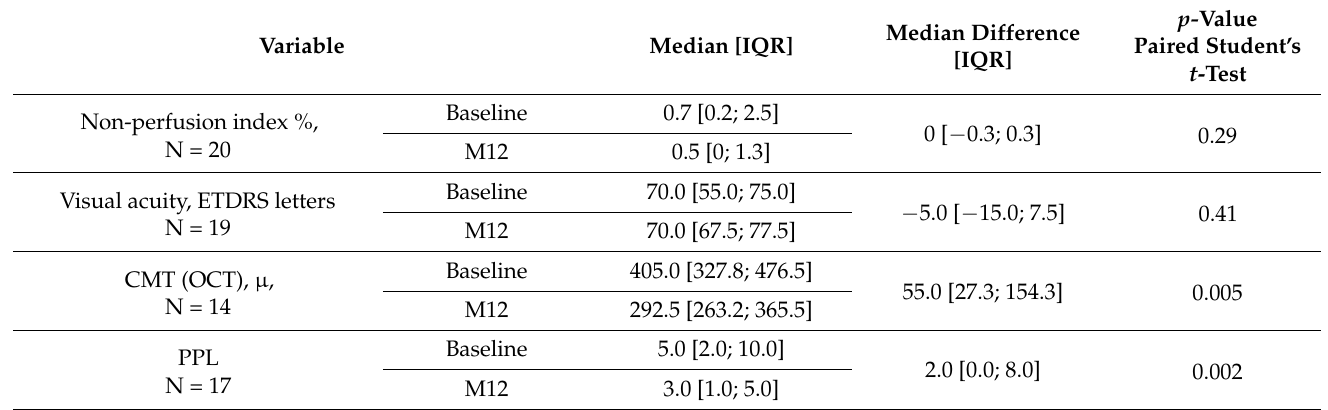
Table 3. Changes in ETDRS score between baseline and month